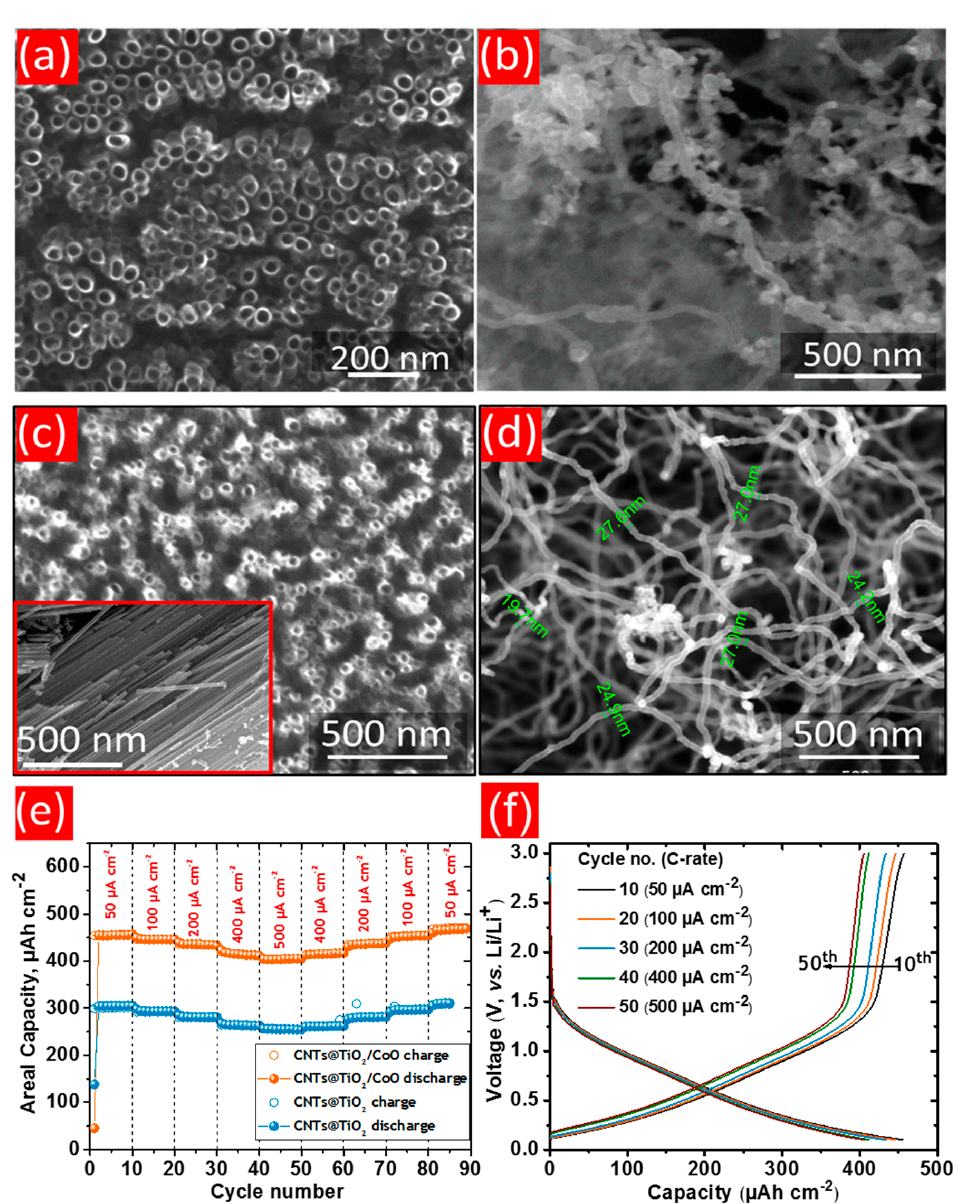
Figure 13. SEM micrographs of uncovered ( a ) TiO 2 nanotubes, ( b ) CNTs@TiO 2 composite, ( c ) TiO 2 -CoO NT, ( d ) CNTs@TiO 2 -CoO NT. ( e ) The electrochemical performance of CNTs@TiO 2 and CNTs@TiO 2 -CoO composite electrodes, ( f ) typical voltage profiles for the 10th, 20th, 30th, 40th, and 50th cycles against areal capacity of TiO 2 -CoO NT anodes, adapted with permission from ref. [162].